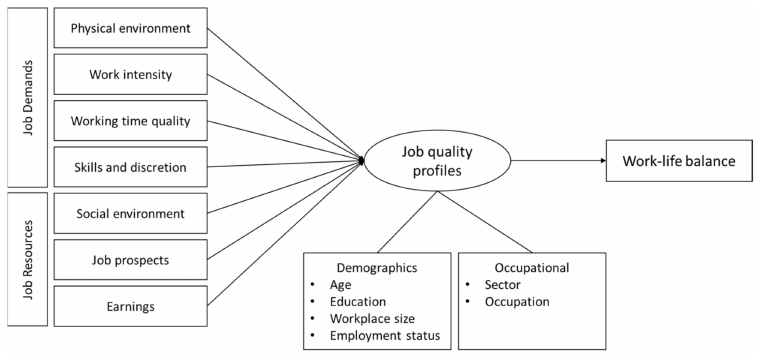
Figure 1. Theoretical framework of this